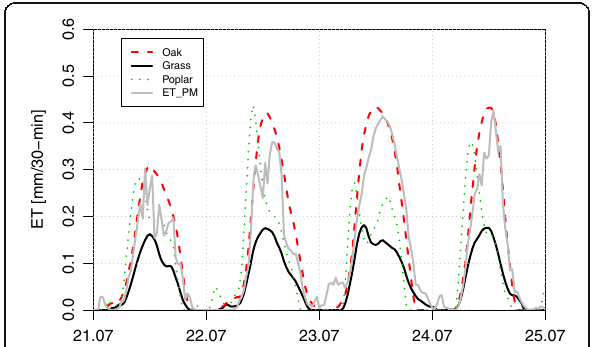
Fig. 6 ET rates in 30-min frequency (ET_PM means Pennman-Monteith